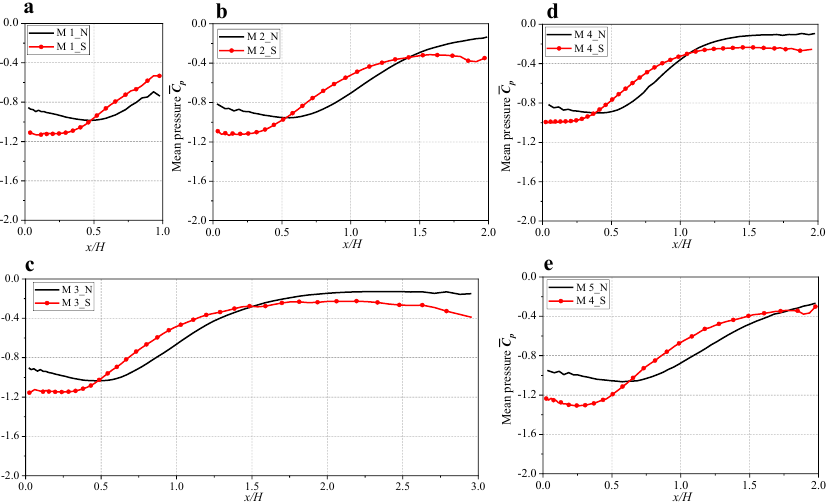
Figure 11. The distributions of mean pressure coefficient ( C P ) along the roof axis (( a ) M1; ( b ) M2; ( c ) M3; ( d ) M3; ( e ) M4).